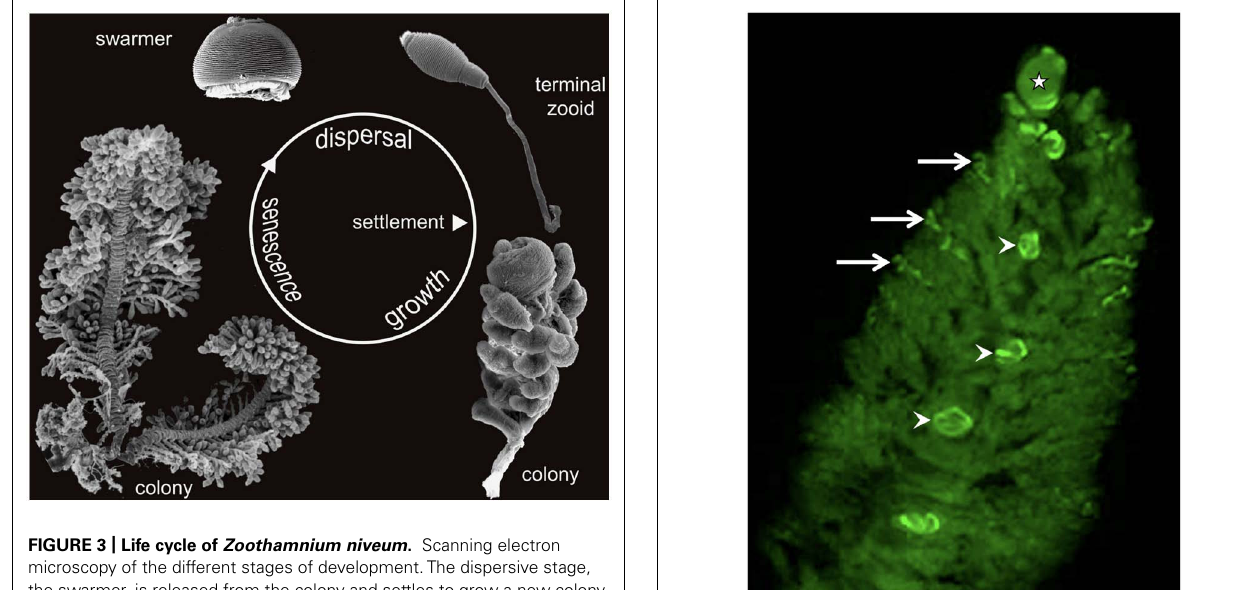
FIGURE 4 | General view of a Zoothamnium niveum colony showing the immunolocalization of BrdU incorporated into proliferating cells. Labeled nucleus are observed in the terminal top zooid, some of the terminal branch zooids and in the macrozooids located along the stalk. Modified from Kloiber etal.